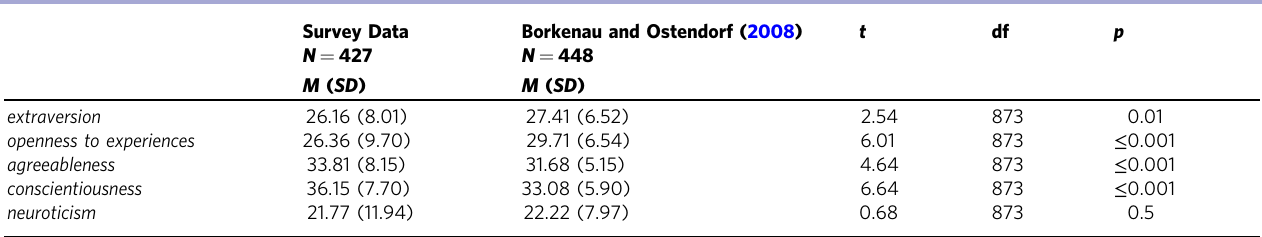
Table 4 Ratings on the NEO-FFI-30; Comparisons of own data (Survey Data) with representative sample (Borkenau and Ostendorf,